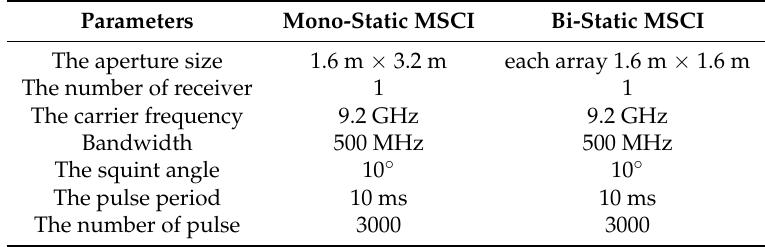
Table 1. The simulation parameters of mono-static and bi-static